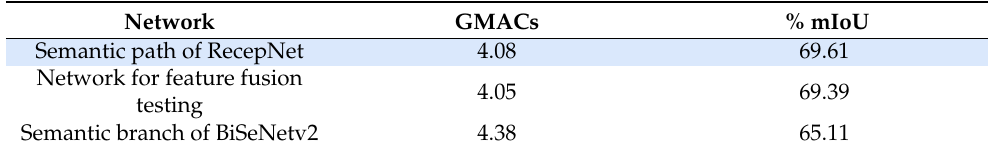
Table 7. Performance of stem